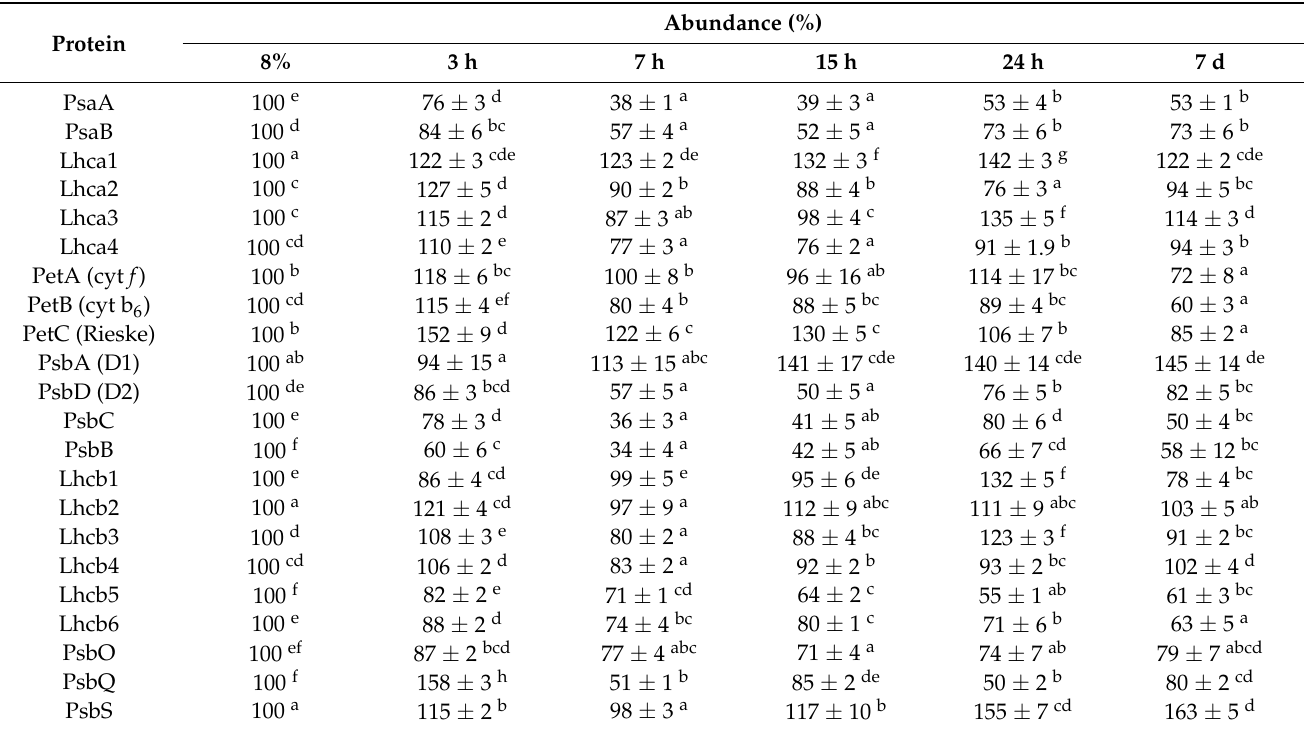
Table 3. Changes in the main photosynthetic proteins of H. rhodopensis plants during rehydration after freezing-induced desiccation (RAF). 8%—dried plant; 3, 7, 15 and 24 h—hours after rehydration; 7 d—7 days after rehydration. The abundances of proteins are presented in percentage of the dried plants’ values (8% RWC). Values are given as mean ± SE. The same letters within a graph indicate no significant differences assessed by the Fisher LSD test ( p ≤ 0.05) after performing ANOVA. The changes in the content of the respective protein between RAD (Table 2) and RAF were statistically